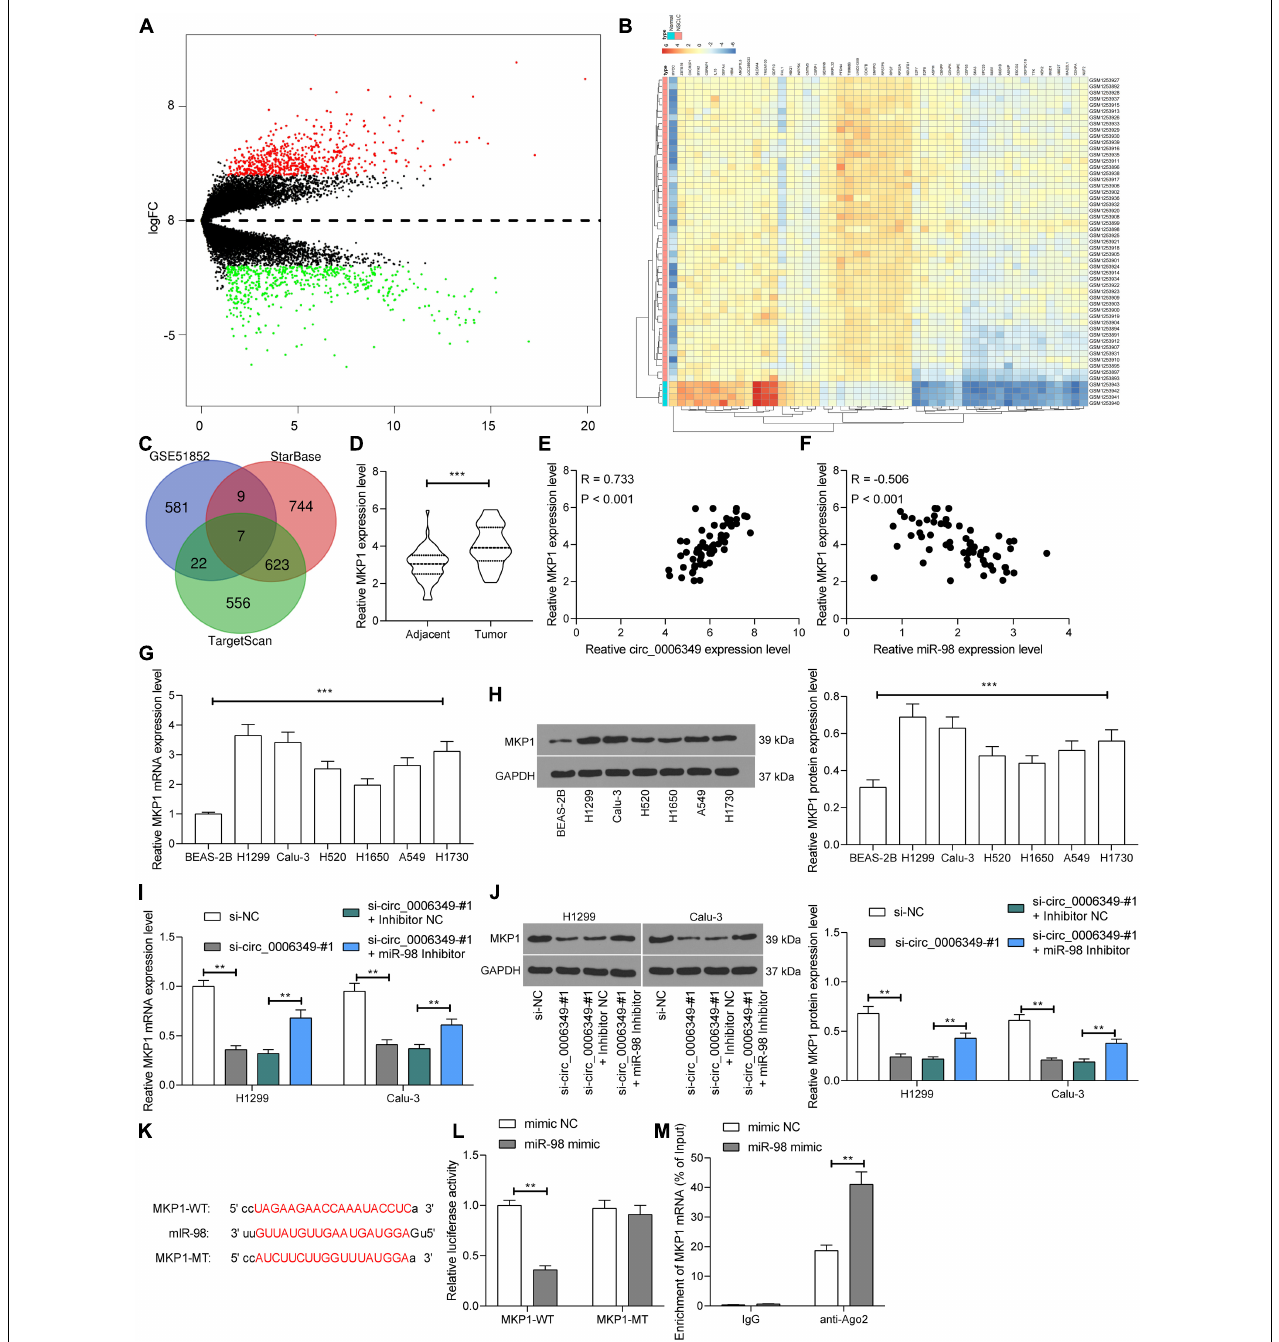
FIGURE 6 | miR-98 directly binds to MKP1 mRNA. (A) Volcano plots for the differentially expressed mRNAs in the GSE51852 dataset; (B) a heatmap for to 50 differentially expressed mRNAs in the GSE51852 dataset; (C) a Venn diagram for the intersections of target mRNAs of miR-98 and the differentially expressed mRNAs in NSCLC; (D) mRNA expression of MKP1 in tissue and normal tissues in 59 NSCLC patients determined by RT-qPCR; (E) a positive correlation between MKP1 expression and circ_0006349 in tumor tissues according to the Pearson’s correlation test; (F) a negative correlation between MKP1 expression and miR-98 in tumor tissues according to the Pearson’s correlation test; (G,H) mRNA (G) and protein (H) expression of MKP1 in BEAS-2B and NSCLC cells determined by RT-qPCR and western blot analysis, respectively; (I,J) mRNA (I) and protein (J) expression of MKP1 in Calu-3 and H1299 cells after si-circ_0006349 or miR-98 inhibitor transfection determined by RT-qPCR and western blot analysis, respectively; (K) sequences of the MKP1-WT and MKP1-MTL vectors for luciferase assay; (L,M) binding relationship between miR-98 and MKP1 mRNA validated through dual luciferase reporter gene (L) and anti-Ago2-RIP (M) assays. Differences were compared by paired t test (D) , one-way (G,H) or two-way ANOVA (I,J,L,M) . All data were presented as the mean ± SD from three independent experiments. ** p < 0.01; *** p < 0.001.